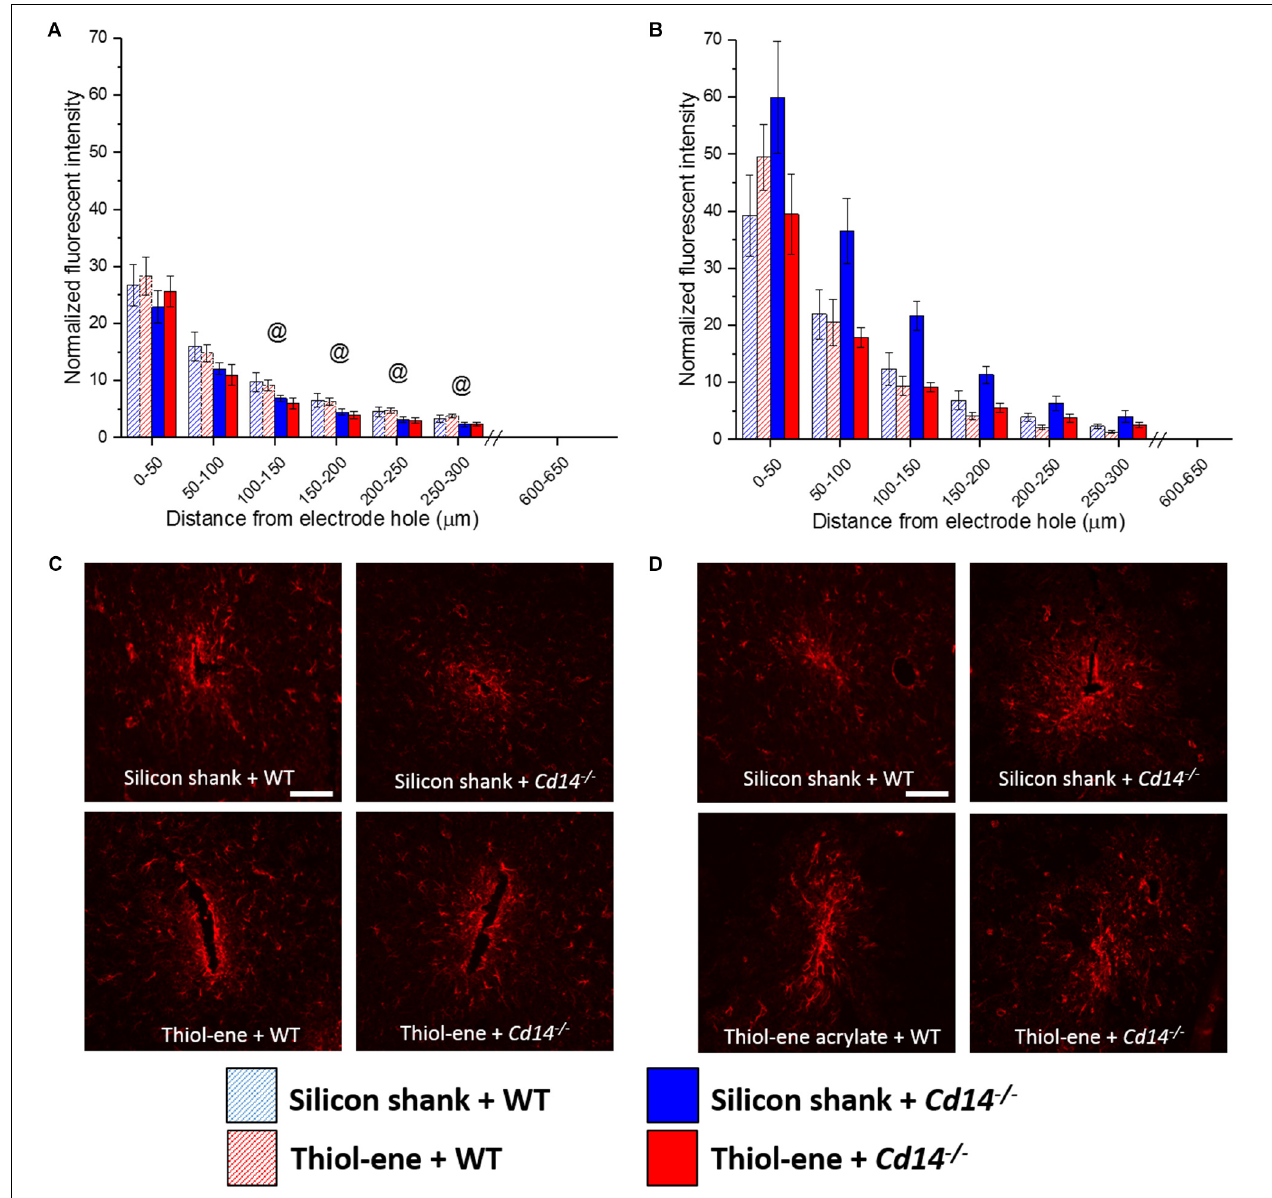
FIGURE 3 | Immunohistochemical evaluation of glial scarring assessed via astrocyte encapsulation. Astrocyte encapsulation evaluated as GFAP expression with respect to distance from the explanted microelectrode hole ( µ m). (A) 2 weeks. (B) 16 weeks. (C) Representative images of 2 weeks glial scar. (D) Representative images of 16 weeks glial scar. Scale bar: 100 µ m. @ Denotes significance between WT and Cd14 − / −